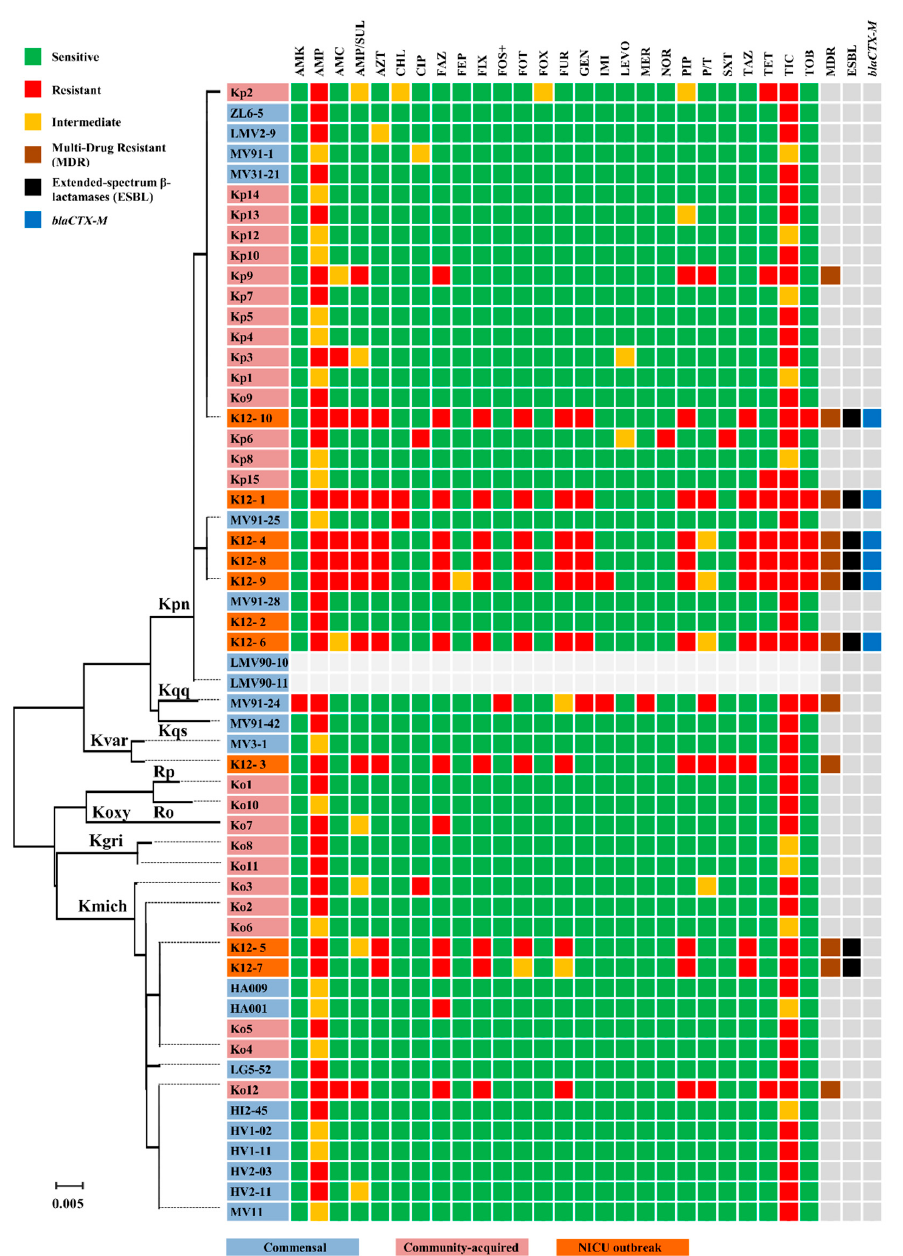
Figure 2. Antibiotic resistance profiles among the Klebsiella isolates analysed in this study: Antibiotics: amikacin (AMK), ampicillin (AMP), amoxicillin–clavulanic acid (AMC), ampicillin-sulbactam (AMP/SUL), aztreonam (AZT), chloramphenicol (CHL), ciprofloxacin (CIP), cefazolin (FAZ), cefepime (FEP), cefixime (FIX), fosfomycin (FOS), cefotaxime (FOT), cefoxitin (FOX), cefuroxime (FUR), gentamicin (GEN), imipenem (IMI), levofloxacin (LEVO), meropenem (MER), norfloxacin (NOR), piperacillin (PIP), piperacillin-tazobactam (P/T), trimethoprim-sulfamethoxazole (SXT), ceftazidime (TAZ), tetracycline (TET), ticarcillin (TIC) and tobramycin (TOB).